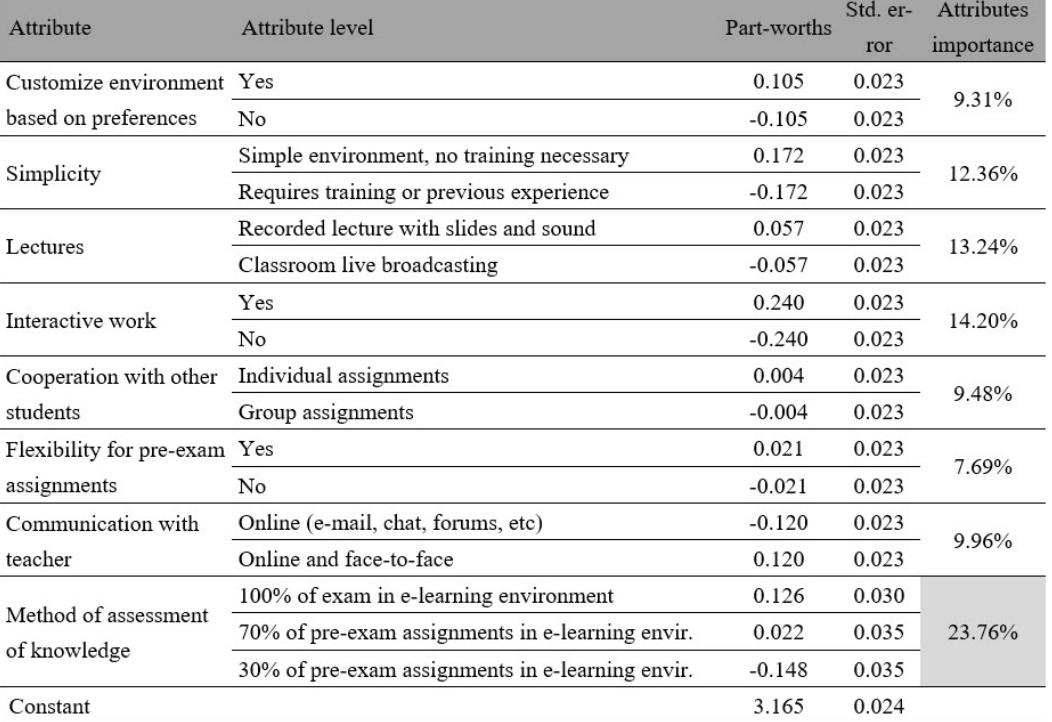
Table 3. Aggregated part-worth utilities and importance of e-learning